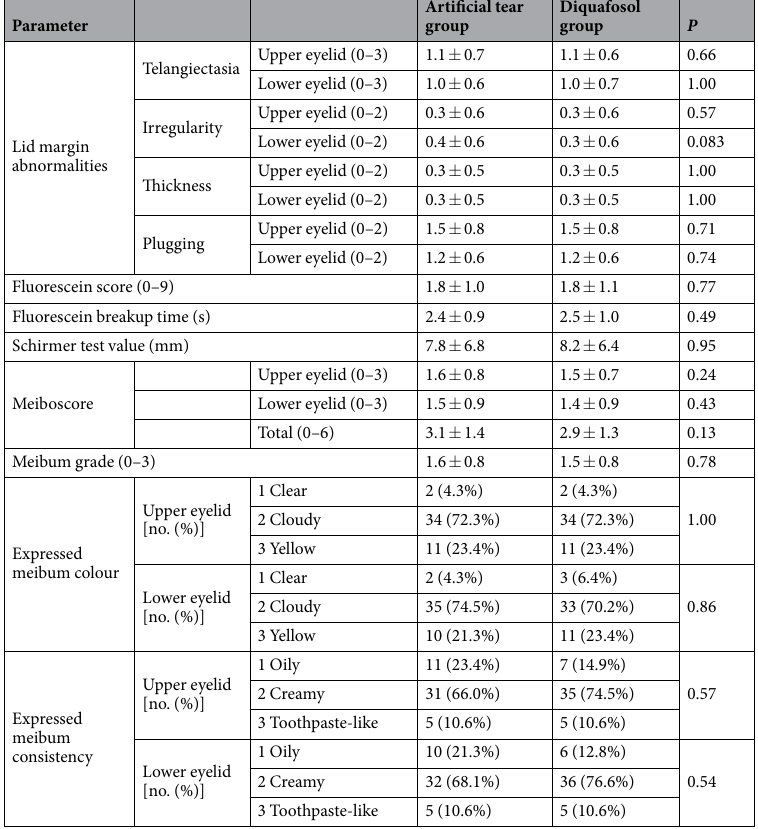
Table 1. Baseline ocular objective parameters for the artificial tear group and the diquafosol group of the dry eye patients with meibomian gland dysfunction ( n = 47). Data are shown as means ± standard deviations. P values were obtained with the Wilcoxon signed-rank test or chi-square